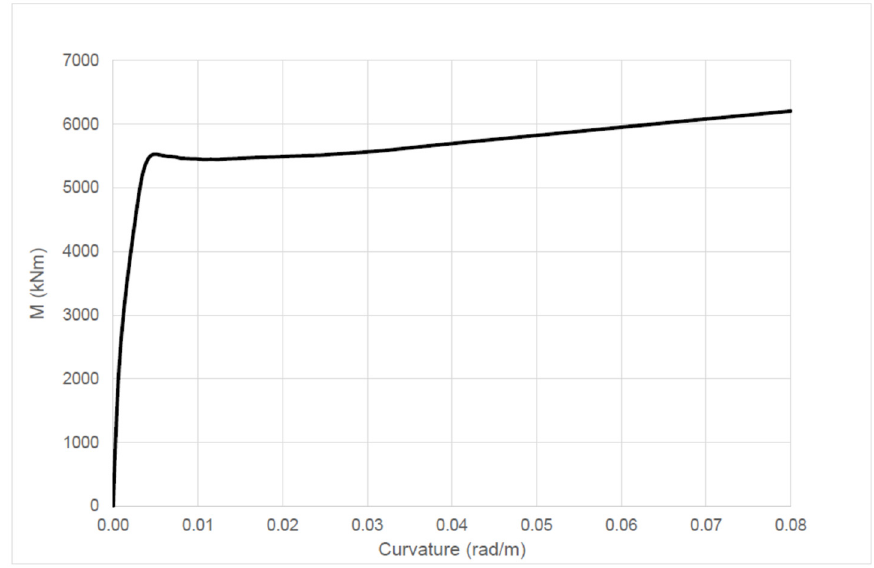
Figure 7. Moment-Curvature. Table 5. Structural elements characteristics. Table 3. Concrete02 (Core and Cover) characteristics.